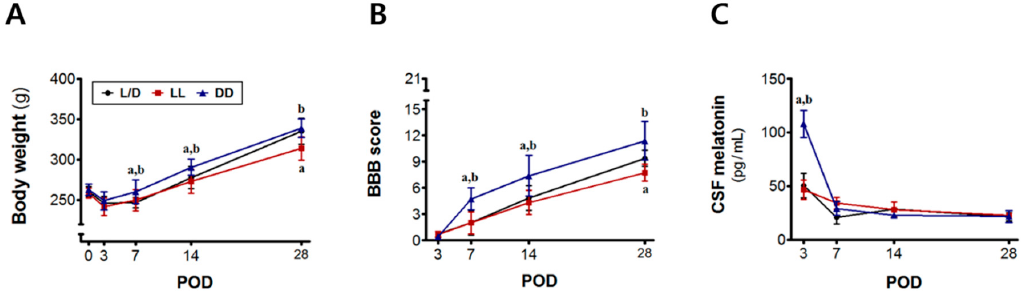
Figure 2. Spontaneous motor recovery of spinal cord injured animals and time-dependent changes of endogenous cerebrospinal fluid (CSF) melatonin. ( A ) There were significant differences in the changes of body weight among the spinal cord injury (SCI) groups were observed. Animals caged in the constant dark condition showed greater body weight from postoperative days (POD) 7 compared to other groups; ( B ) Spontaneous behavioral recovery was suppressed under LL condition, but DD condition enhanced motor function after the seven postoperative days (POD) compared to natural light/dark cycle; ( C ) Cerebrospinal fluid (CSF) was collected between ZT13 and ZT15 under the light/dark cycle. Endogenous CSF melatonin was more concentrated at POD 3 under DD condition, but the mean value did not differ thereafter. L/D, 12/12-h light/dark; LL, 24-h constant light; DD, 24-h constant dark. a p < 0.05, vs. L/D; b p < 0.05, vs. LL.